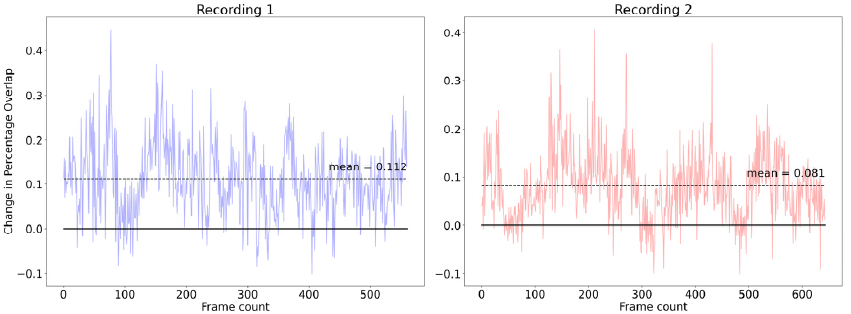
Figure 10. Change in frame-to-frame segmentation consistency for two sample recordings, with